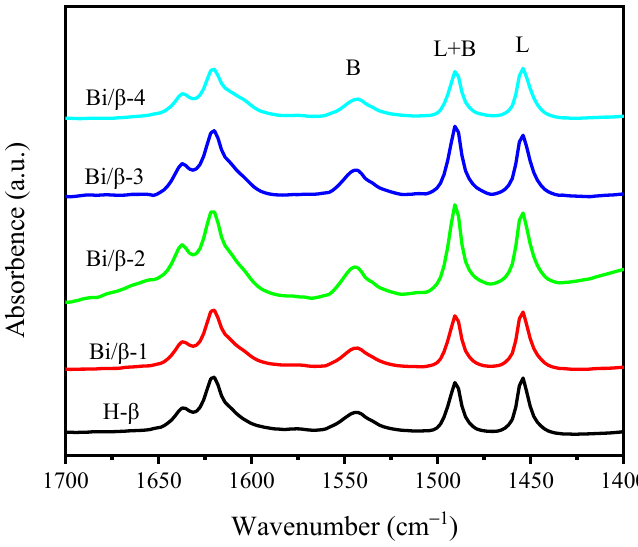
Figure 7. PyIR profiles of H/ β and various Bi/ β catalysts with different Bi loading. Table 2. Acidity of H- β and Bi/ β zeolite